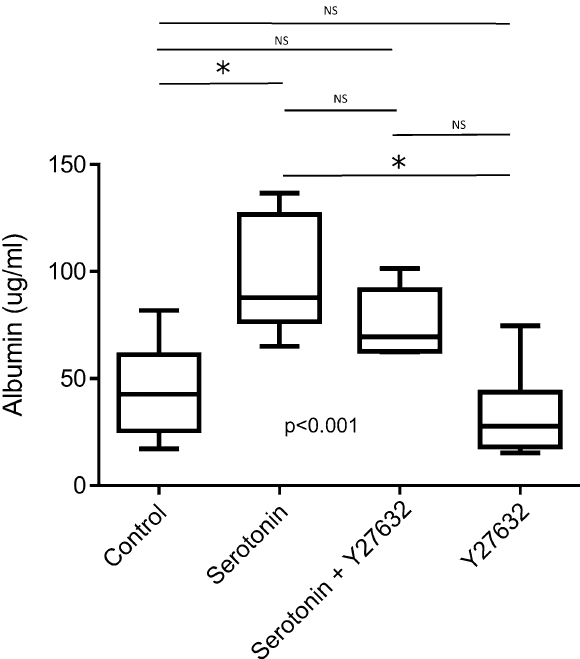
Figure 4. Effect of 5-HT on endothelial cell permeability. Albumin differences among control, serotonin-added, serotonin and ROCK inhibitor (Y27632)-added, and ROCK inhibitor-added groups by Kruskal–Wallis test and Steel–Dwass test for post-hoc analysis, are shown. *p < 0.05 by Steel–Dwass